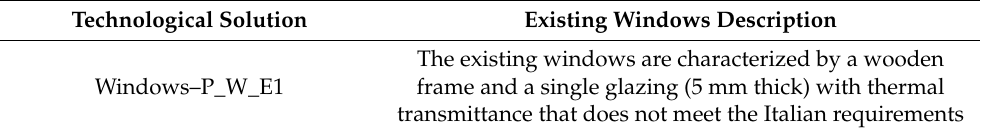
Table A7. Existing windows characteristics (P_W_E1).